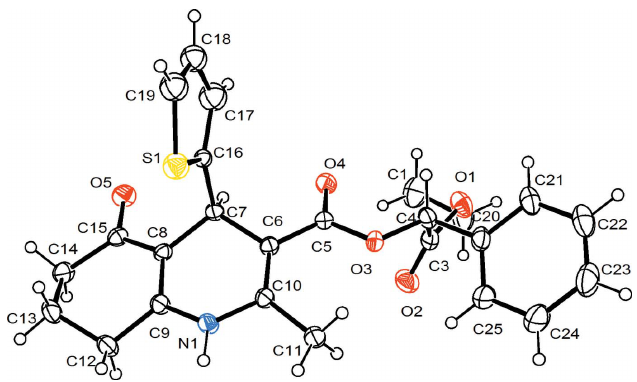
Figure 1 The molecular structure of the title compound with the atom-numbering scheme and 50% probability displacement ellipsoids. Only the major component of the disordered thienyl fragment is